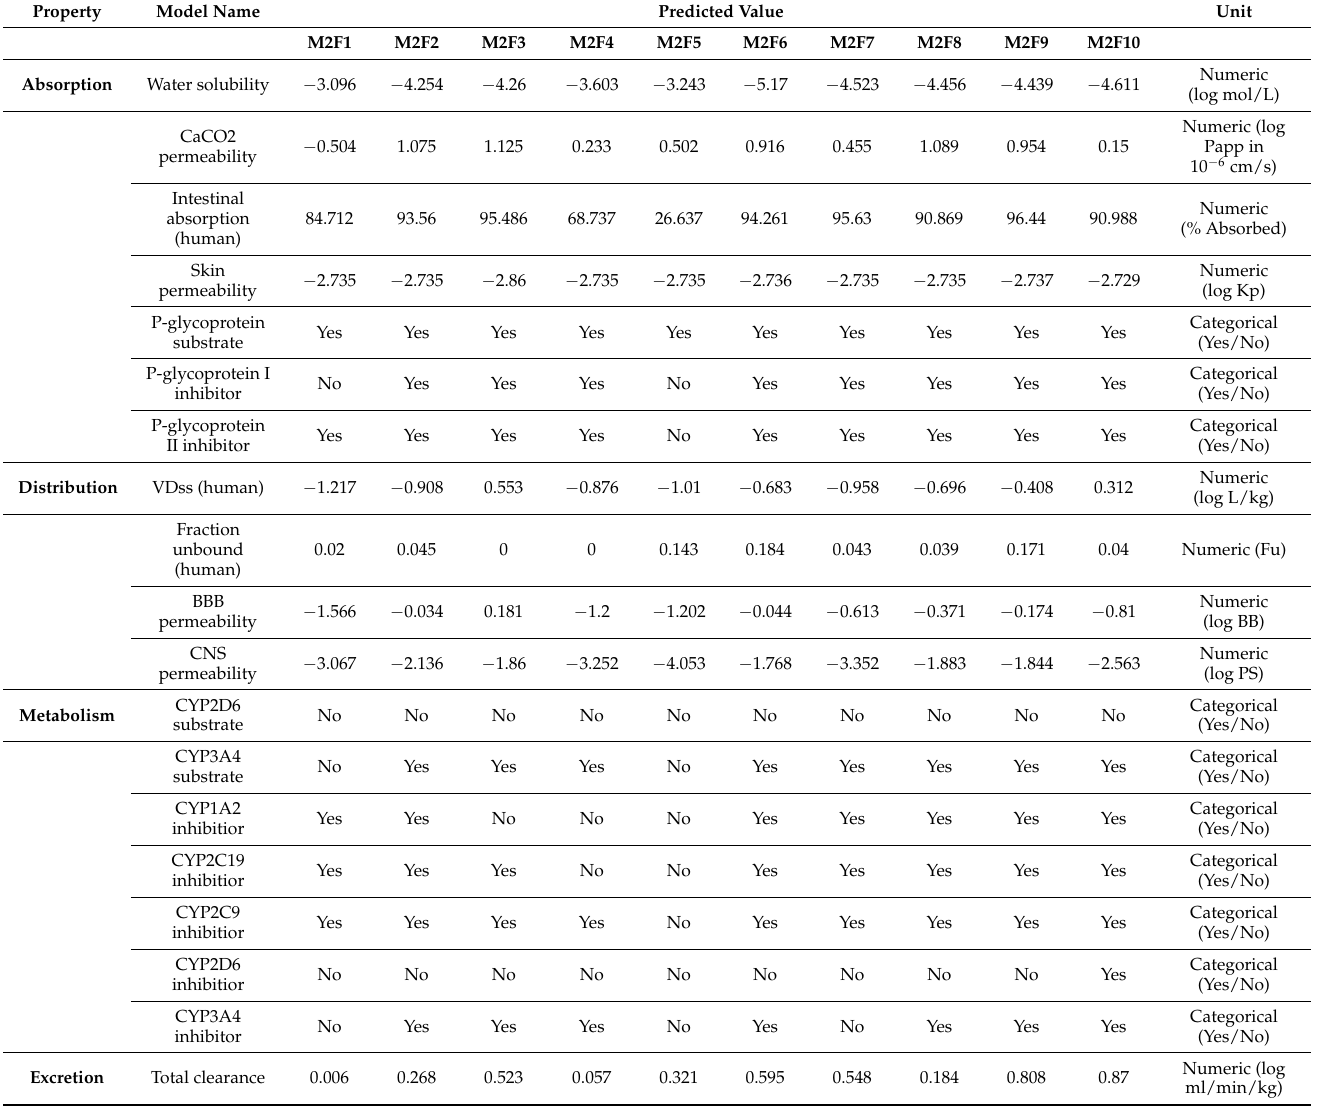
Table 4. ADMET properties of the selected flavonoids against